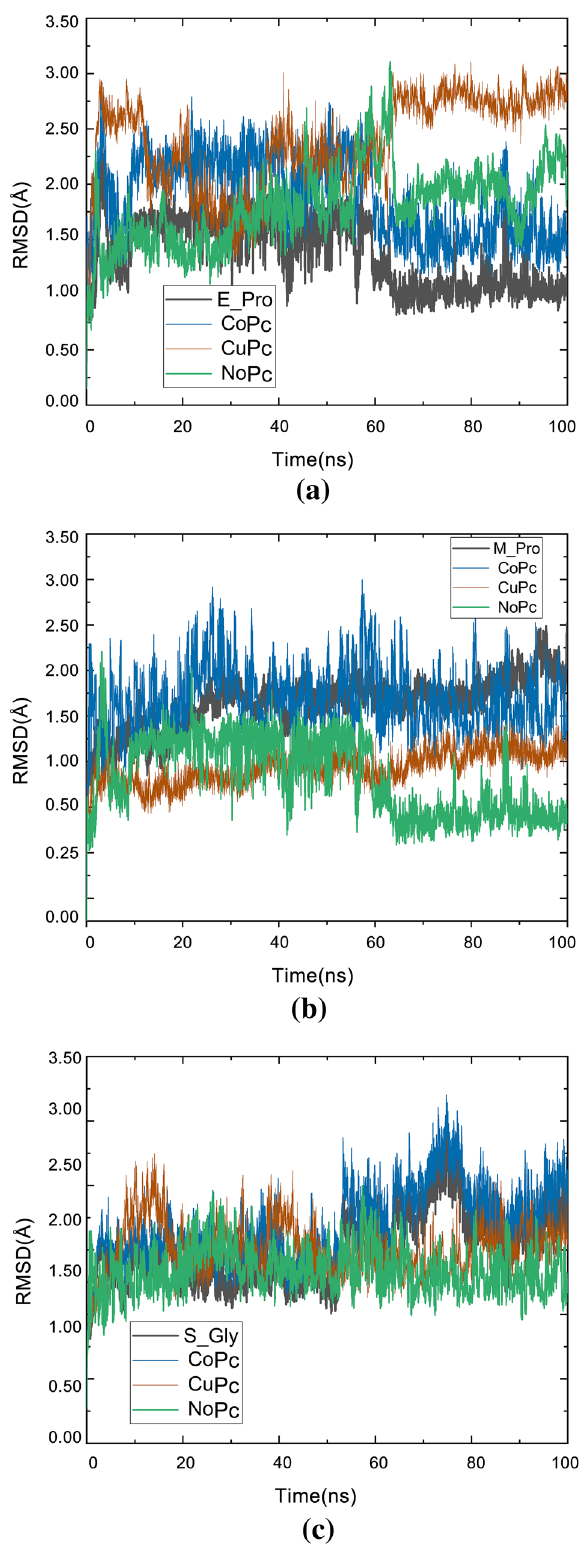
Figure 8. RMSD versus time of ligands with ( a ) E-pro; ( b ) M-pro e ( c )